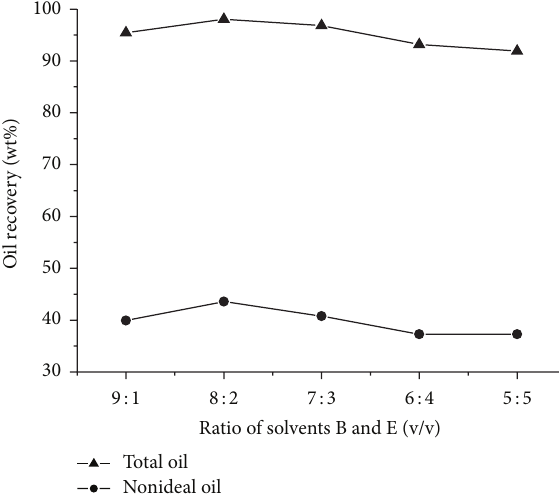
Figure 3: The effect of the ratio of solvents B and